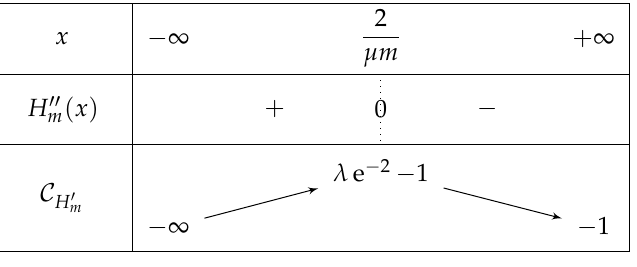
Figure 11. Variations of H (cid:48) m for m >